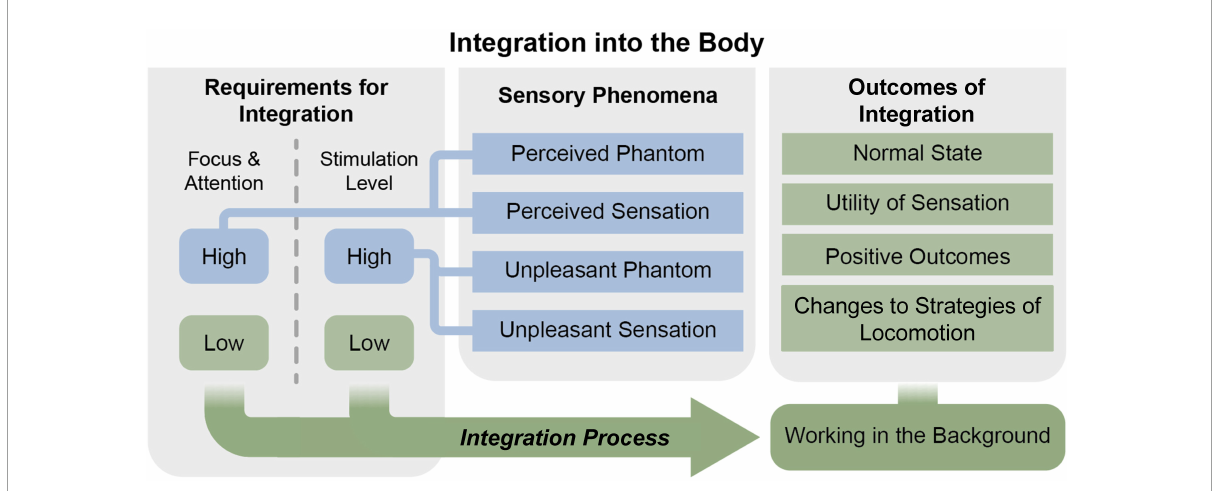
FIGURE3 Theoretical model of the experience of integration of a sensory neuroprosthesis into the body. Gray boxes represent overarching categories and blue and green boxes depict nodes. The blue nodes include conditions and experiences which were not associated with sensorimotor integration of the sensory neuroprosthesis. The integration process (green arrow) occurred when the requirements for integration were met (green boxes, left) and resulted in outcomes of integration (right).